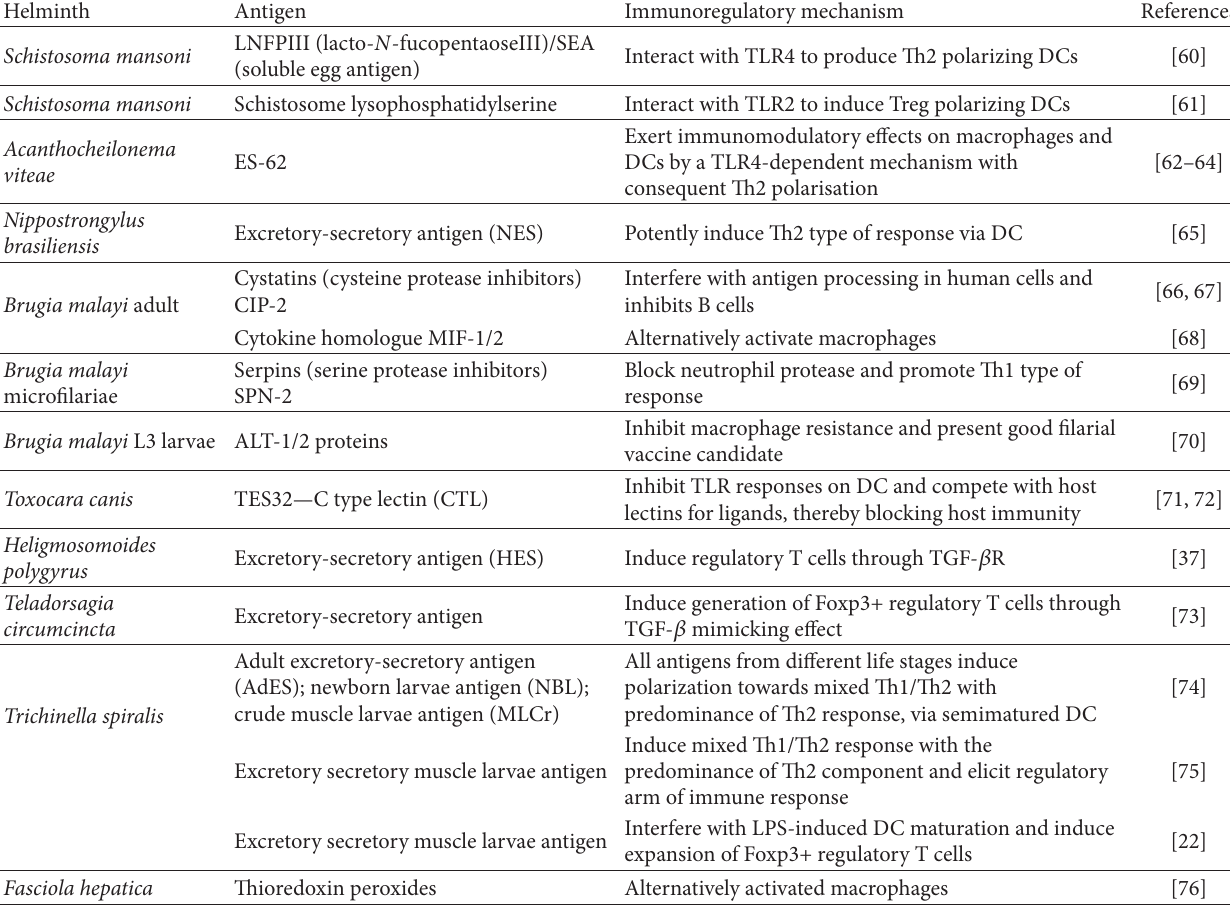
T 1: Helminth-derived antigens with immunoregulatory properties.